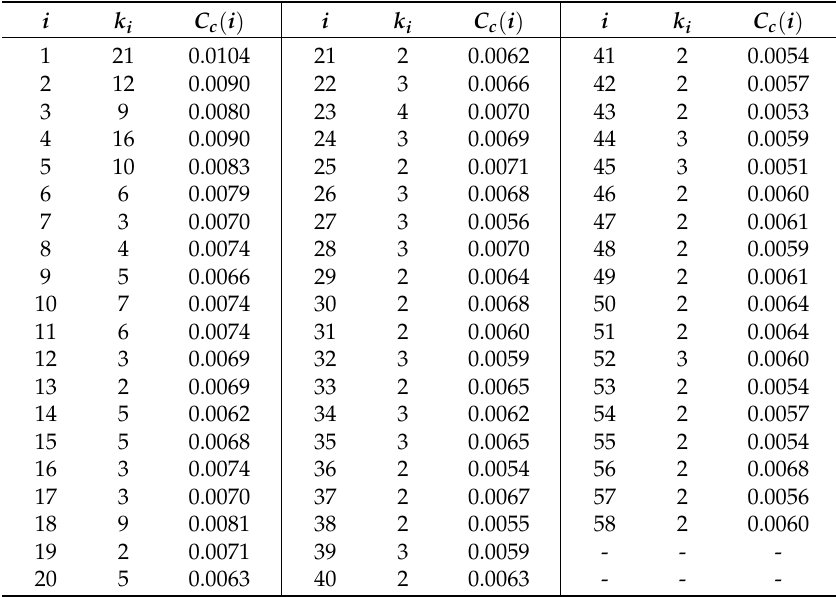
Table A3. The degrees and closeness centralities of cyber